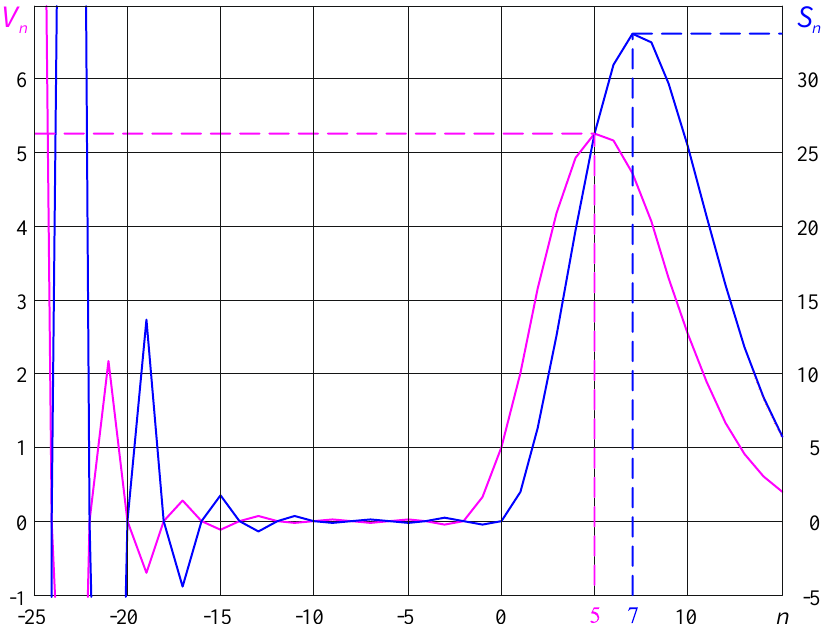
Figure 1. n -ball radius recurrence relation f n for n  ℤ (blue); even (yellow) and odd (black) algebraic forms of f n , and the π ^ ⌊ n /2 ⌋ factor (green); for −7 ≤ n ≤ 7, n  ℂ .